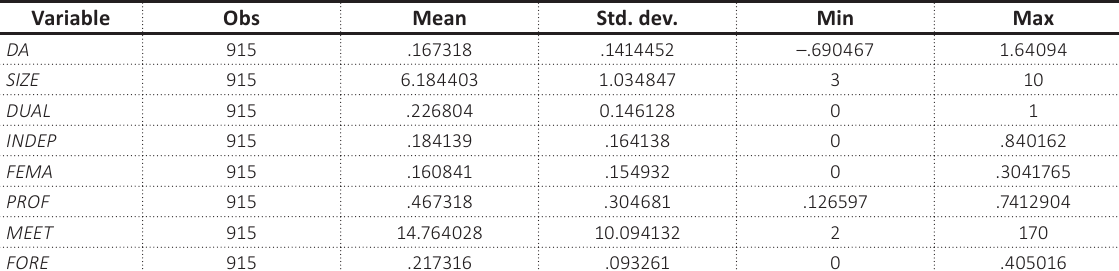
Table 2. Descriptive statistics